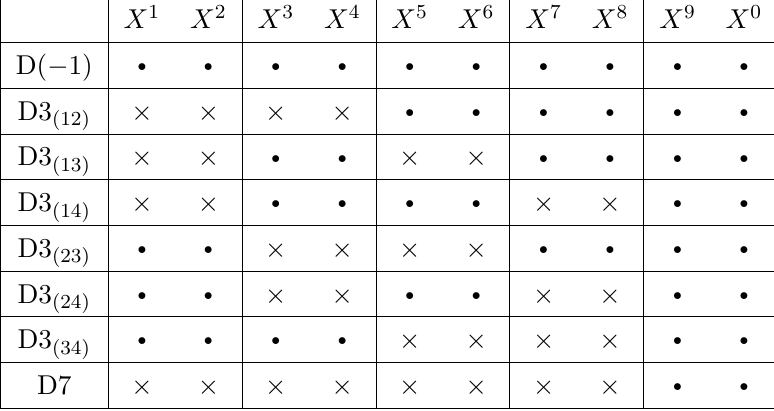
Table 3 . Brane con(cid:12)guration corresponding to general spiked